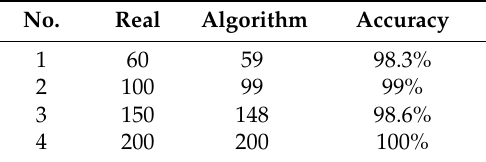
Table 1. Experiment Results of Step